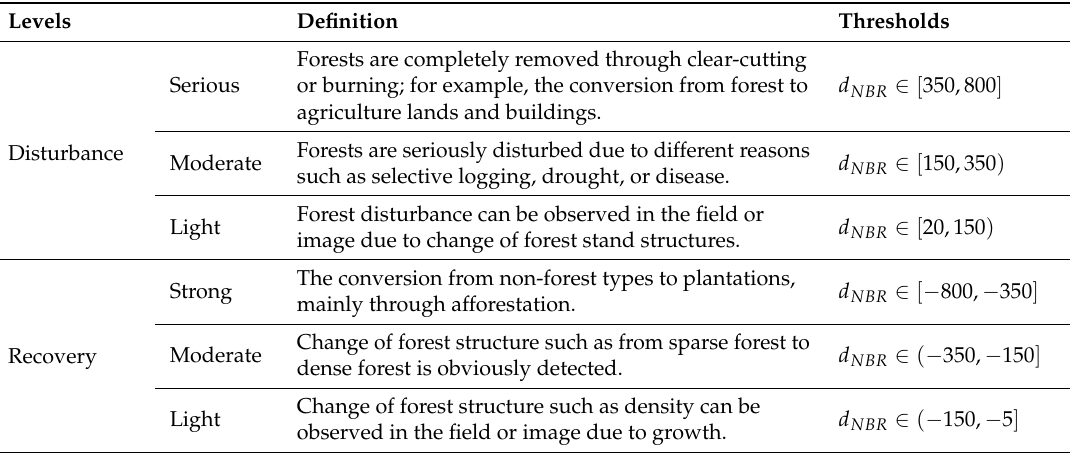
Table 2. Definitions of Different Levels of Forest Disturbances and Recoveries.